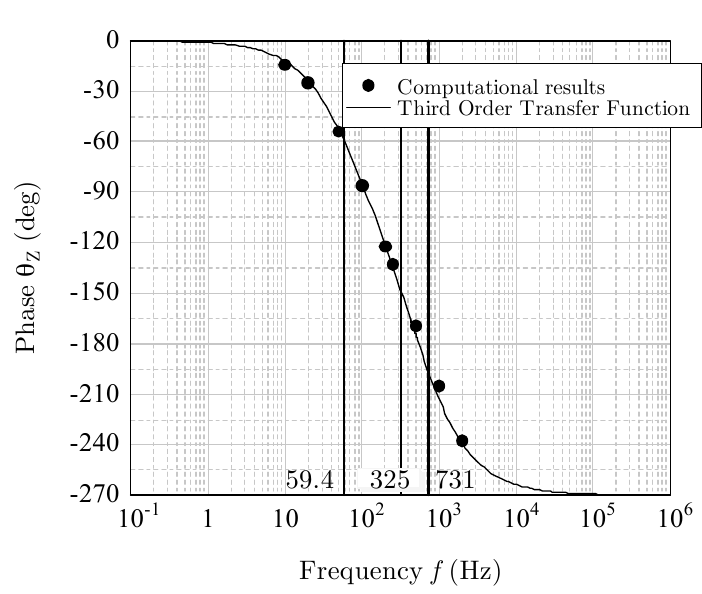
Figure 19. Phase shift for the z -acceleration.